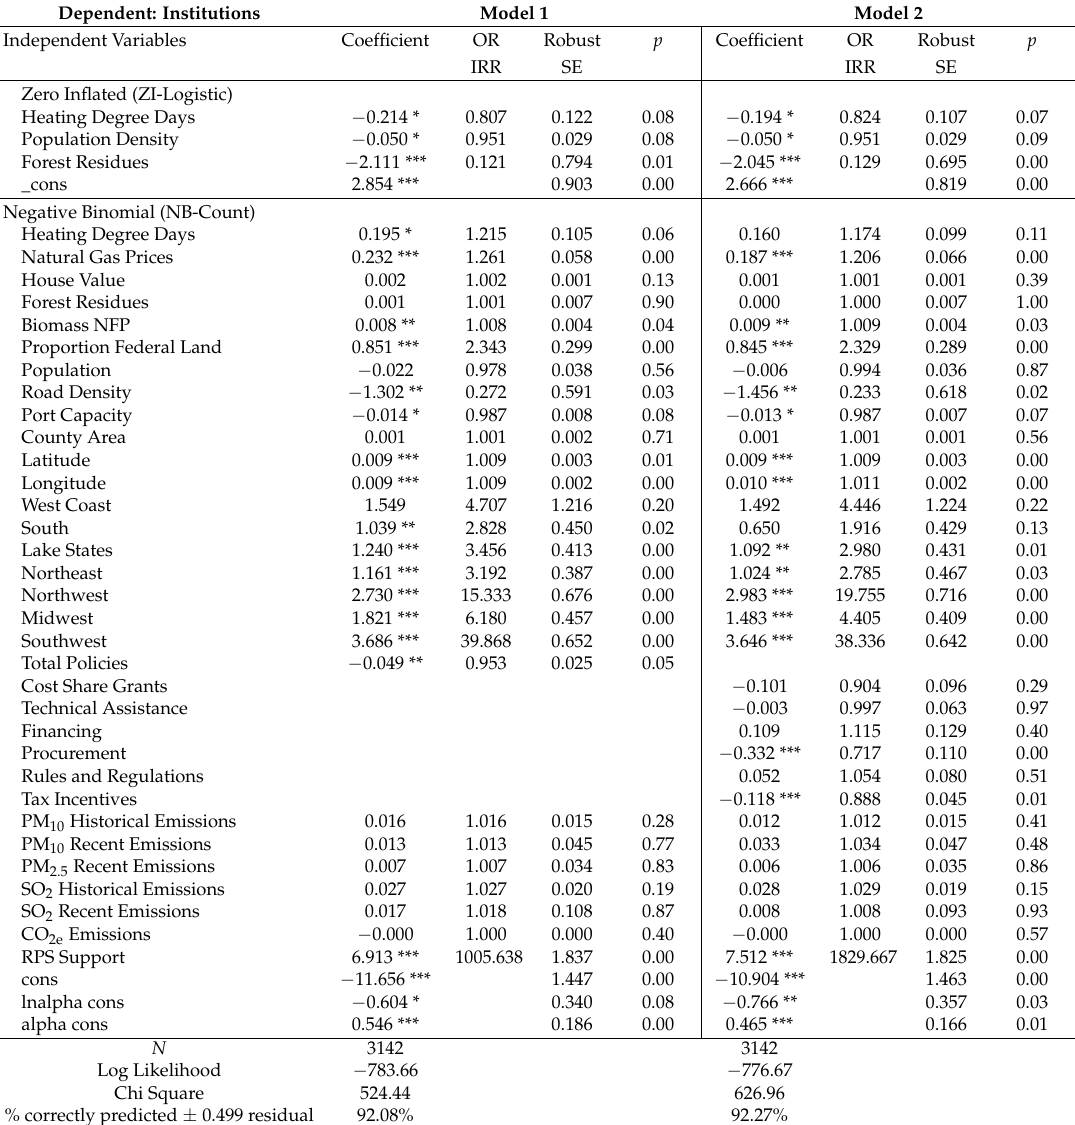
Table 4. Results for the Zero Inflated Negative Binomial (ZINB) Model 1 and Model